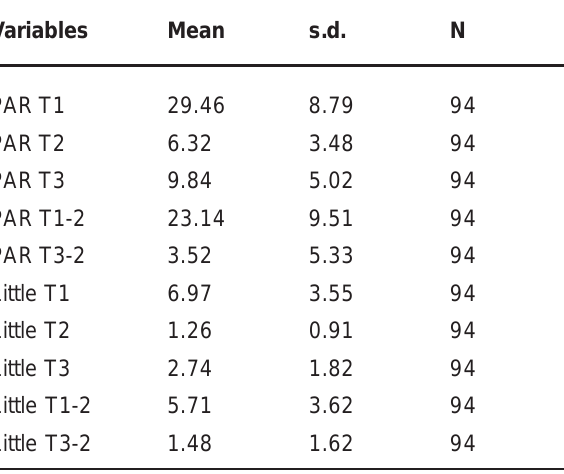
TABLE 2- Descriptive statistics of the variables